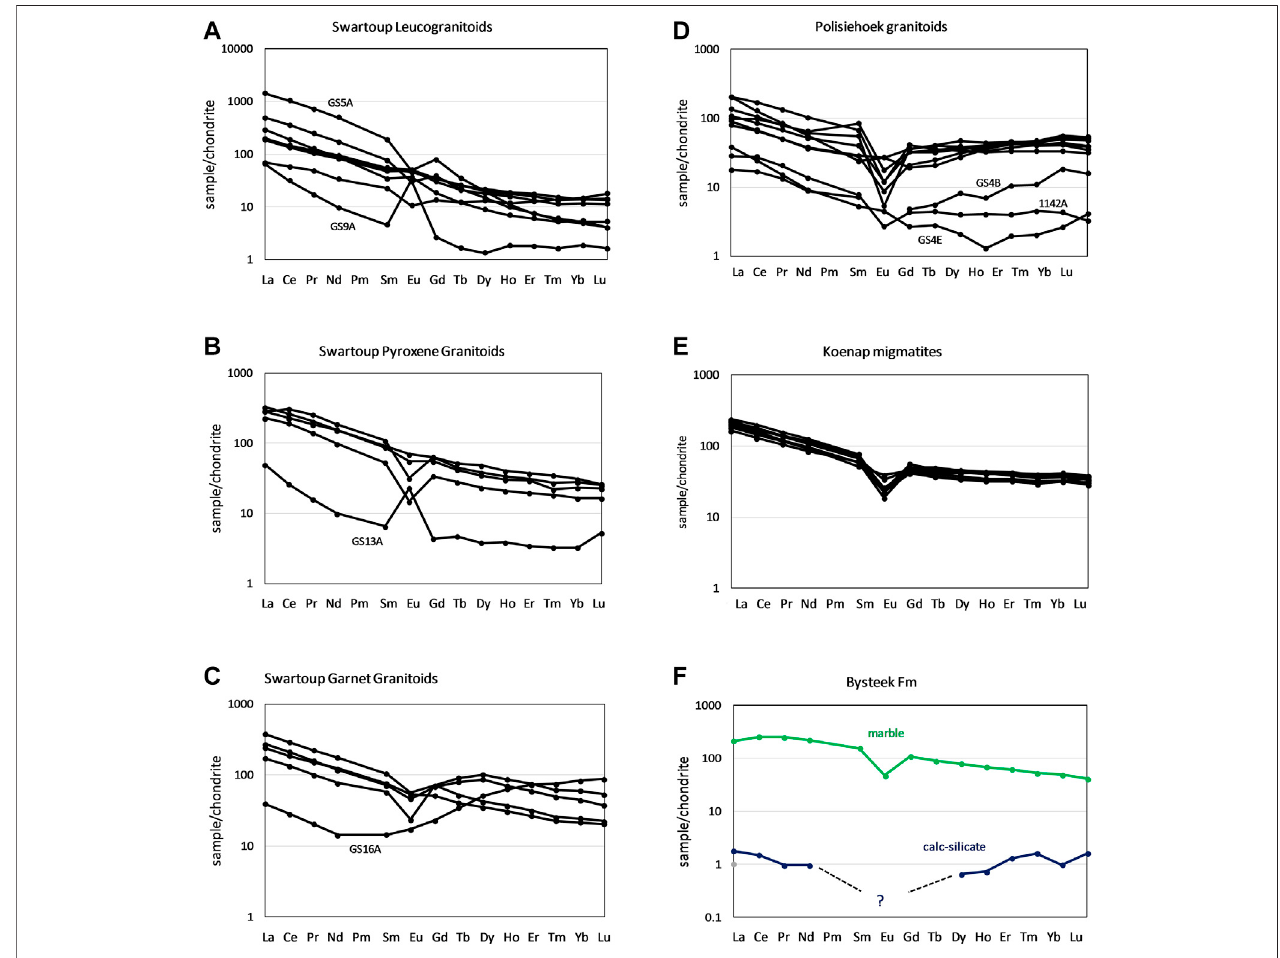
FIGURE6| Chondrite-normalized rare-earth diagramsoftheSwartoupand Polisiehoek plutons and their hostrocks.Compositionally distinctsamplesare labeled and/or distinguished using color.